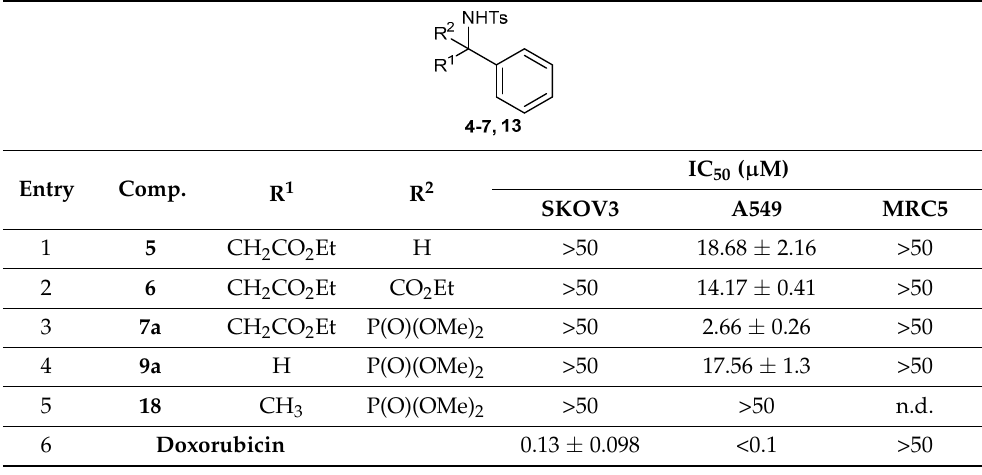
Table 1. Antiproliferative activity of substrates 5–7, 9 and 18 against lung and ovarian cancer cell lines.